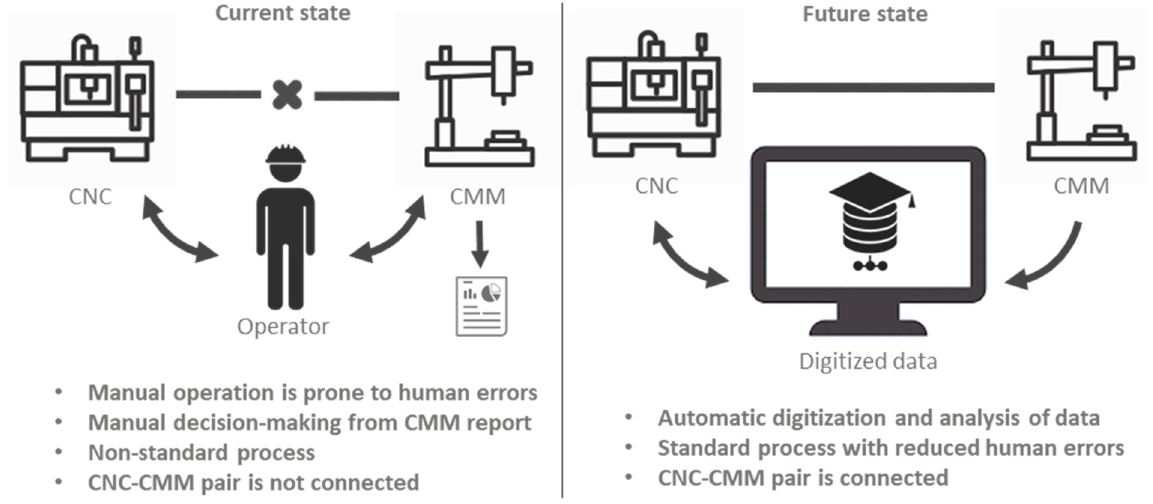
Figure 4. Process map—current and future states.